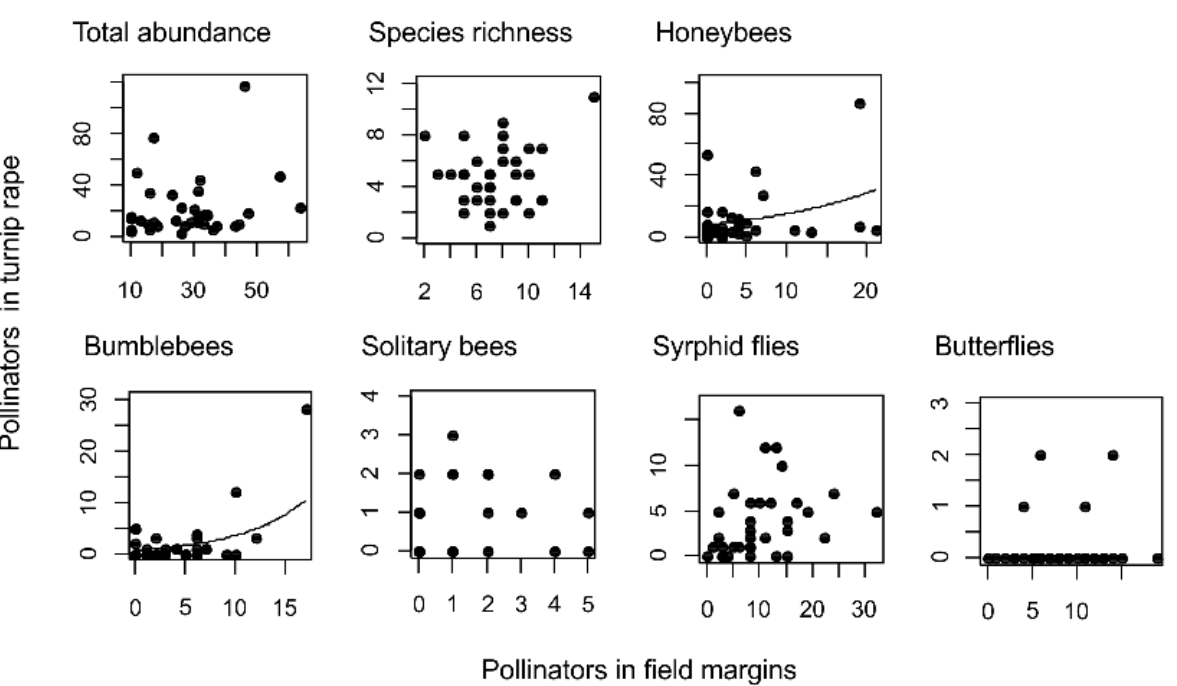
Figure 4. Pollinator abundance and species richness in turnip rape fields in relation to their abundance and species richness in adjacent field margins. Lines in two scatterplots depict predicted values based on statistically significant generalised linear models (Tab.